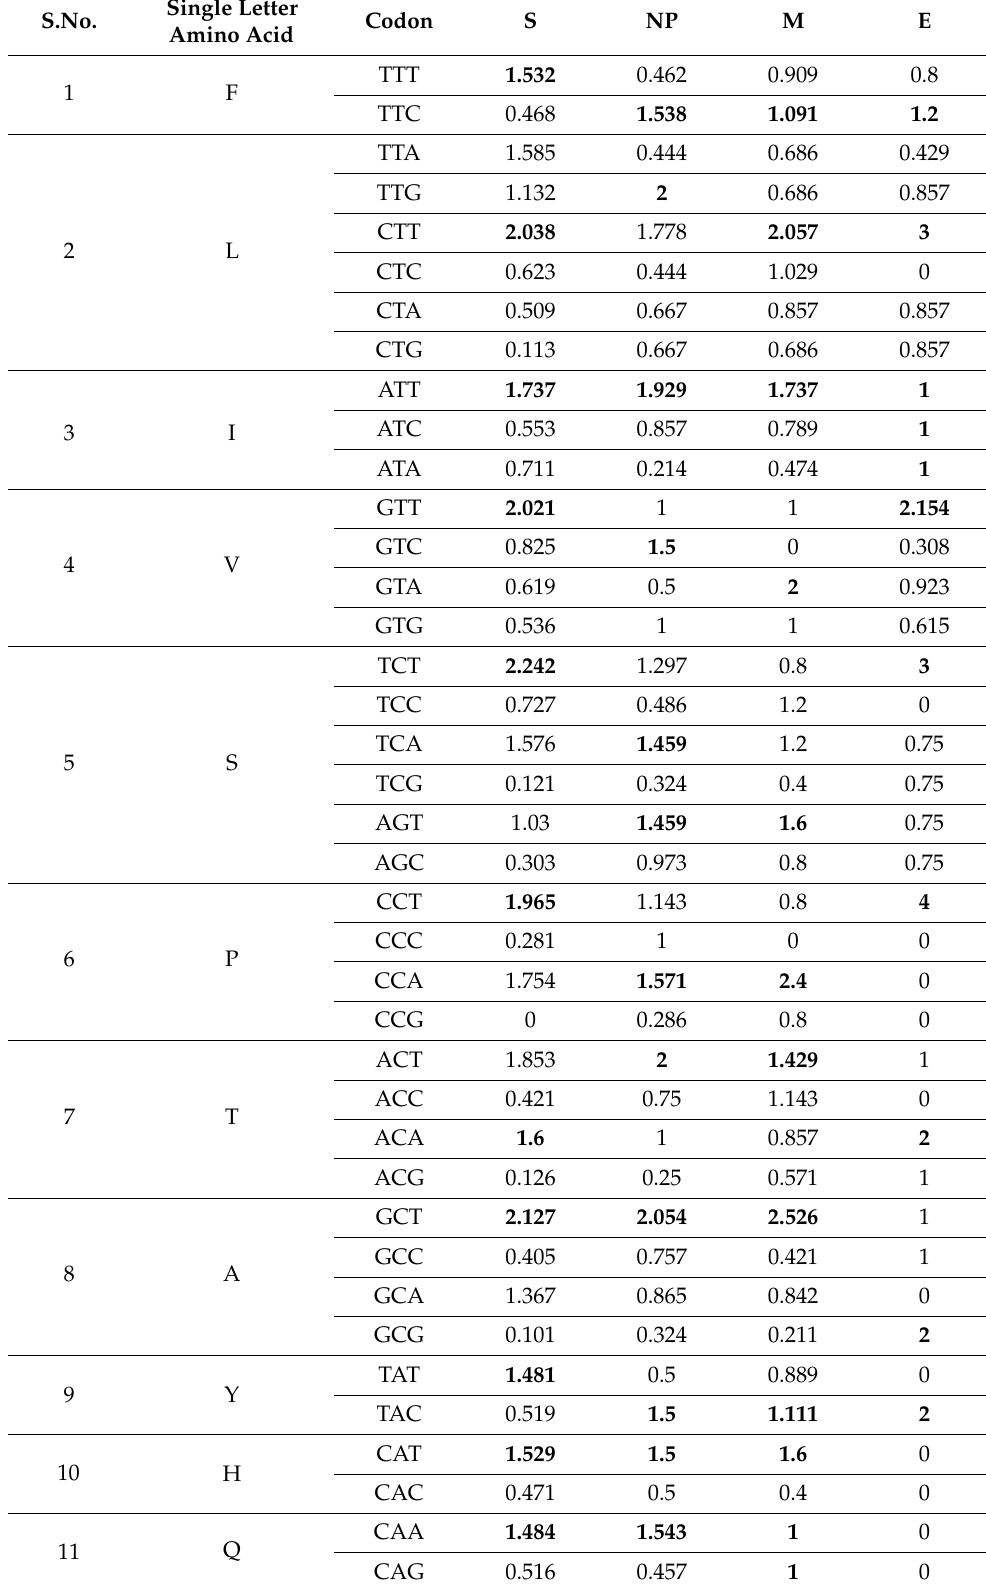
Table 2. The most preferred codon among synonymous codons in structural